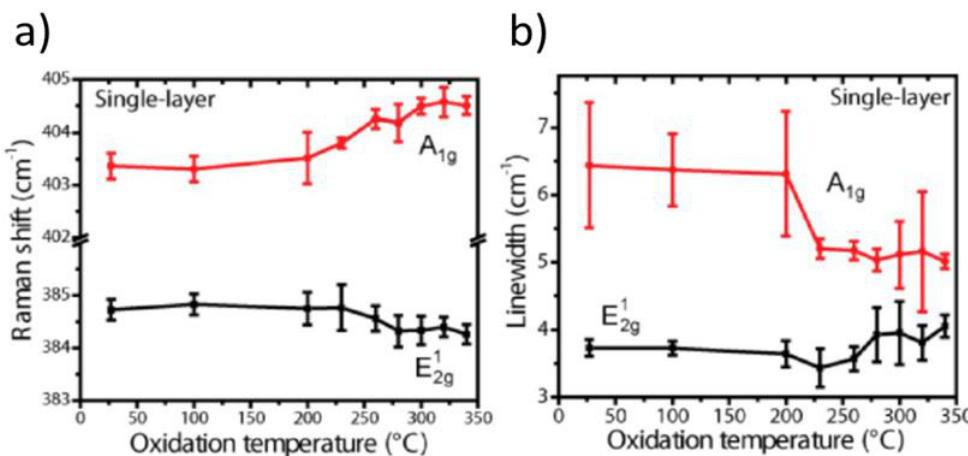
Figure 8. Raman studies of A 1g and E 12g bands on single-layer MoS 2 as a function of heating temperature. ( a ) Raman shifts and ( b ) Linewidths of the investigated modes, respectively. Following the trend set by the behavior of the A 1g mode, the authors of Reference [35] claimed to observe an electron density withdrawal from the MoS 2 layer upon oxidative etching. Reprinted from Reference [35], with permission. Copyright 2013 American Chemical Society.